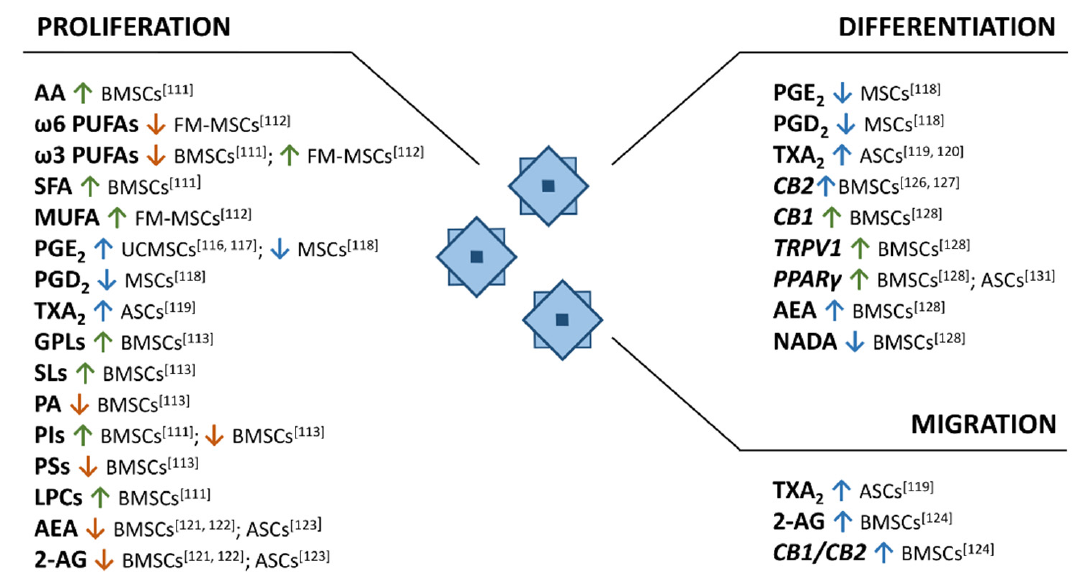
Figure 2. Lipids and their receptors involved in MSCs proliferation, differentiation and migration. The green and orange arrows indicate an increment and a decrease of lipids or their receptors, respectively; whereas blue arrows indicate their action on MSCs. Abbreviations. AA: arachidonic acid; PUFAs: polyunsaturated fatty acids; SFAs: saturated fatty acids; MUFAs: monounsaturated